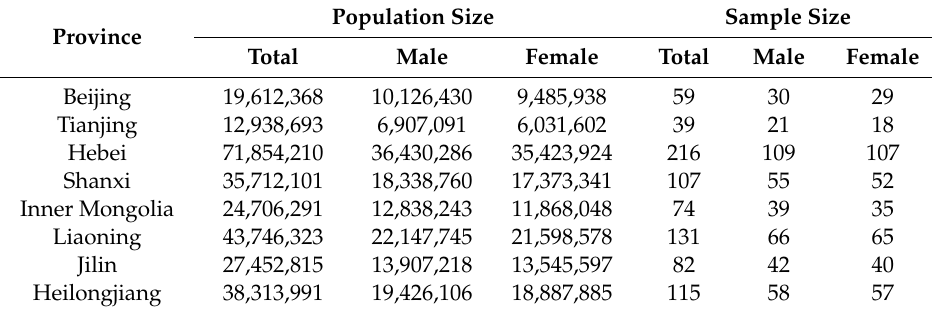
Table A1. The distribution of the